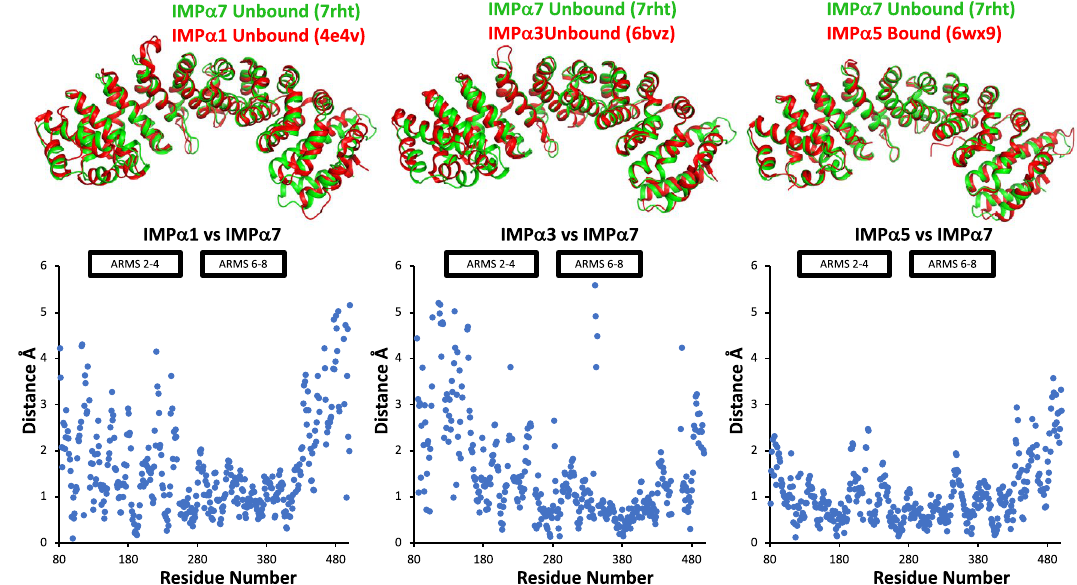
Figure 3. Structural comparisons of unbound IMPα7 with other IMPα subfamily members. IMPα1 (unbound, PDB 4e4v), IMPα3 (unbound, PDB 6bvz), IMPα5 (unbound structure remains to be determined, PDB 6wx9) isoforms were superimposed using CCP4 Superpose and the structural differences analyzed (see graph inset). The positions of the ARM domains 2–4 and 6–8, mediating cargo binding at the major and minor sites, respectively, are highlighted in bold.